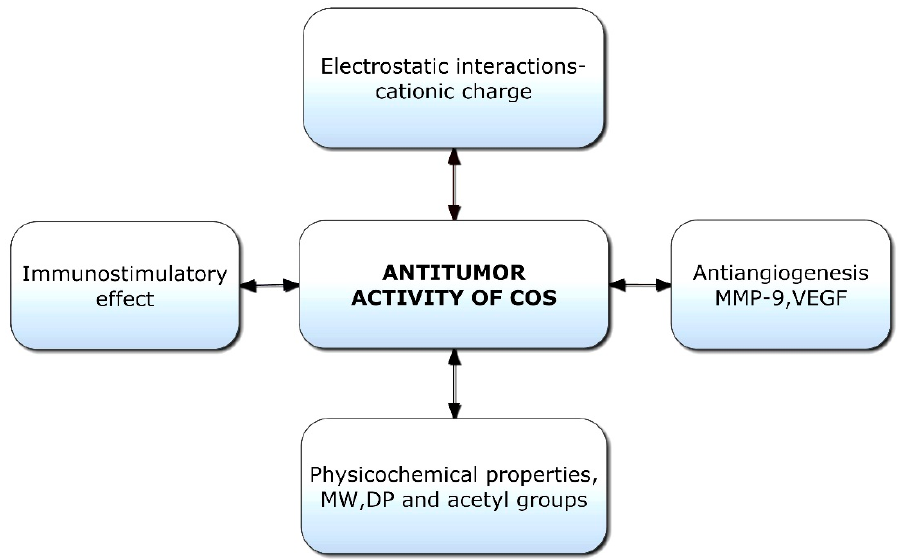
Figure 5. Potential factors responsible for antitumor activities of chitooligosaccharides (COSs). VEGF: Vascular endothelial growth factor; MW: Molecular weight; DP: Degree of polymerization.